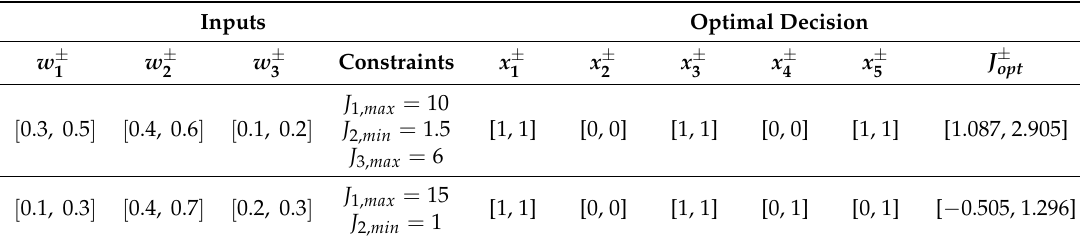
Table 3. Examples with interval weights.